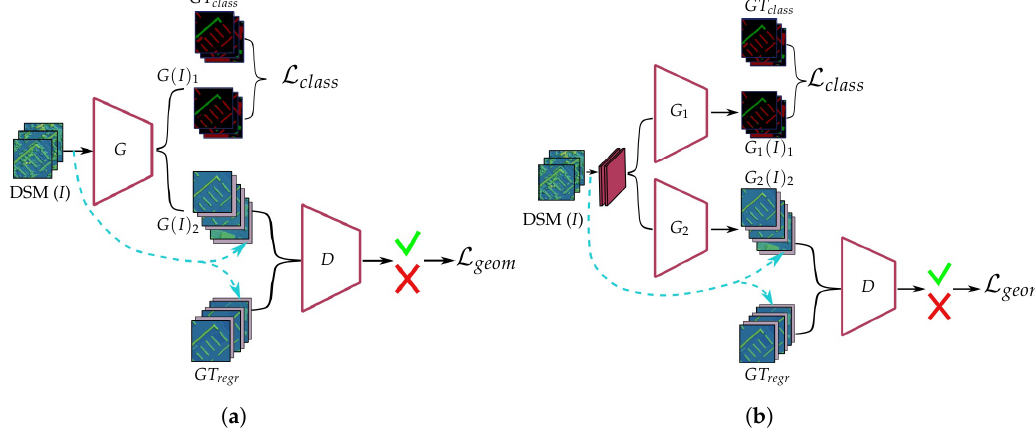
Figure 2. Schematic overview of two investigated architectures with ( a ) a one-stream generator G and ( b ) a two-stream generator G 1 and G 2 for simultaneous building shape refinement G ( I ) 2 and roof classification map G ( I ) 1 generation. The input to both networks is a single photogrammetric digital surface model (DSM) ( I ). The discriminator D is identical for both models. The ground truth for the regression task ( GT regr ) is represented by level of detail (LoD) 2-DSM generated from City Geography Markup Language (CityGML) data. The ground truth for classification task ( GT class ) is obtained from the orientation of the computed slope for each pixel. Each architecture is a conditional generative adversarial network (cGAN) network which conditions ( ) the model on side information such as input photogrammetric DSM. It is concatenated with either generated depth image G ( I ) 2 or ground truth ( GT regr ) as an additional channel ( )beforegoingto D network. Although the multi-task problems G ( I ) 2 and G ( I ) 1 of the two-stream network are depicted as independent